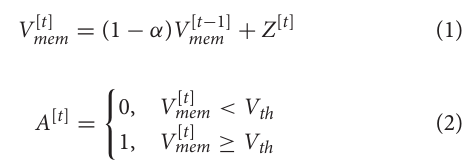
and a corresponding Poisson spike train of fixed duration, with a pre-set maximum firing rate, is generated ( Figure 1